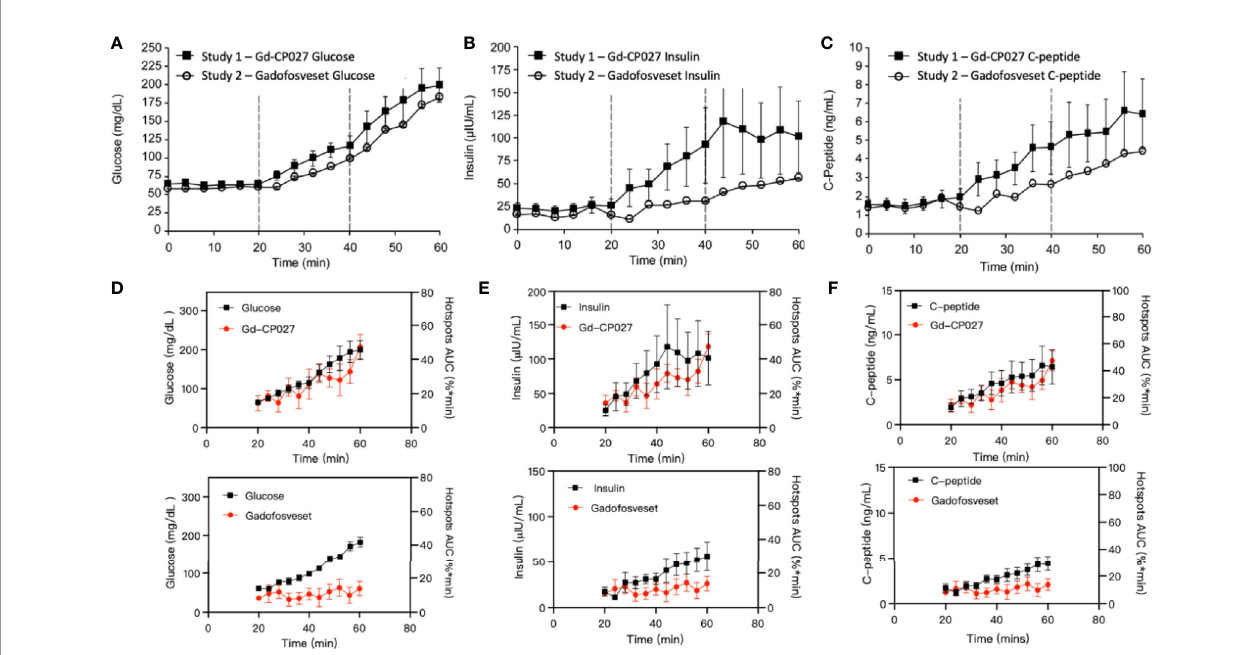
FIGURE 4 | (A) Blood glucose, (B) insulin, and (C) C-peptide levels collected during each GGI study (n = 4). Error bars represent standard error, and vertical dashed lines re fl ect each infusion period. Area under the curve for Gd-CP027 and Gadofosveset hotspots overlapped to blood measurements of (D) Glucose, (E) Insulin, and (F) C-peptide.